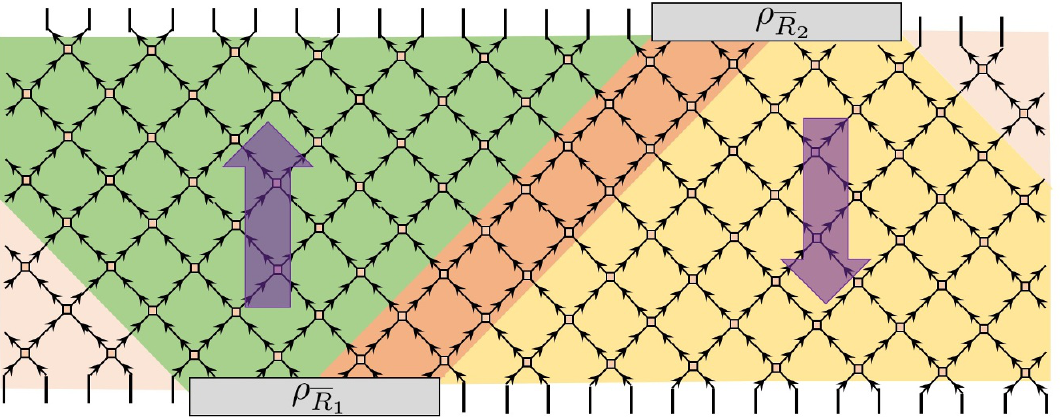
Figure 10 . In a Trotter network with a special initial state, some causal in(cid:13)uence can be lost.